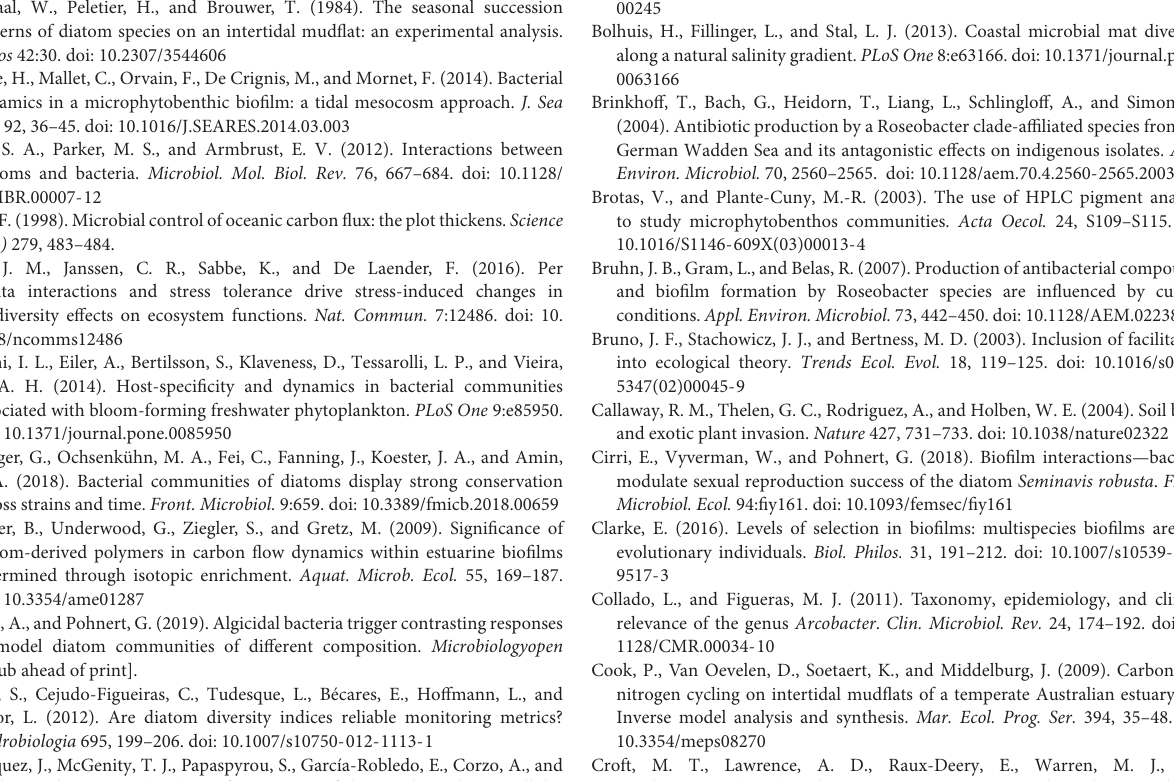
00245 Bolhuis, H., Fillinger, L., and Stal, L. J. (2013). Coastal microbial mat